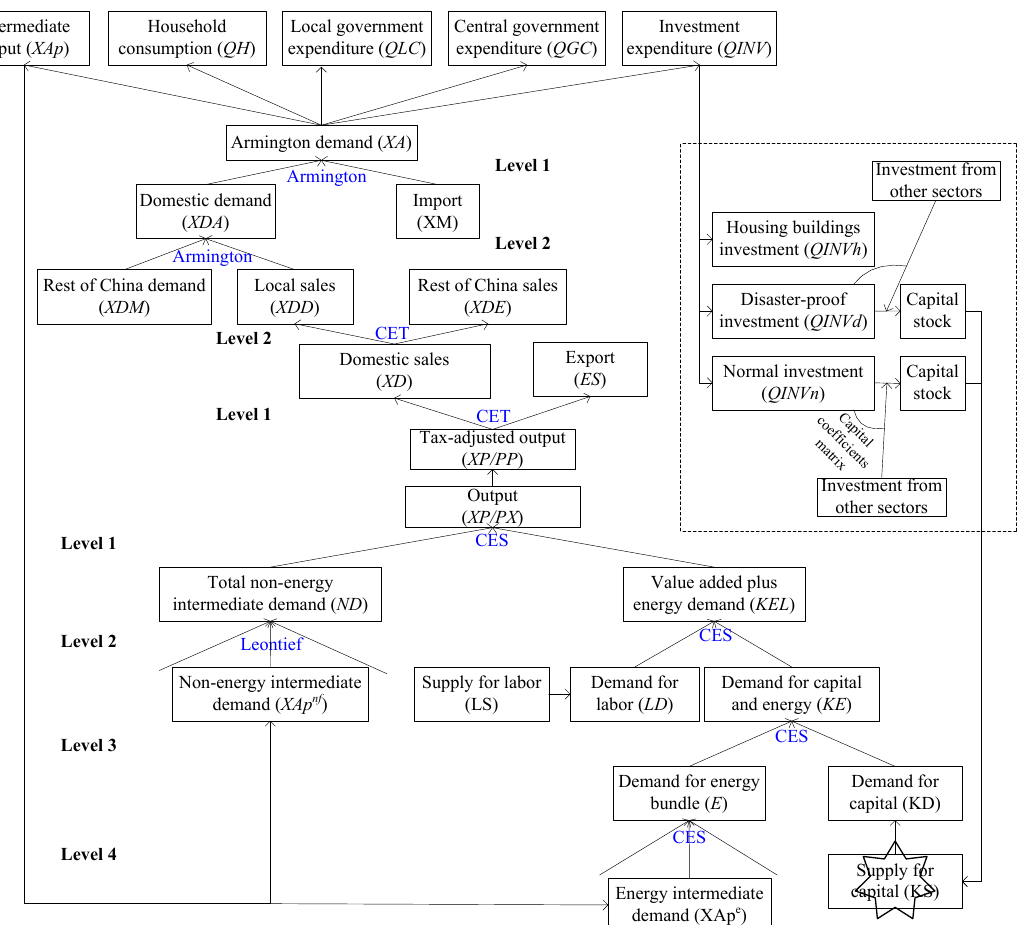
Fig. 2. The framework of the CGE model, which reflects reconstruction following a disaster (non-dotted line box: the traditional CGE model; dotted line box: the reflection of the disaster shocks and the reconstruction following a disaster). Fig. 2. Specifically, during post-disaster reconstruction,